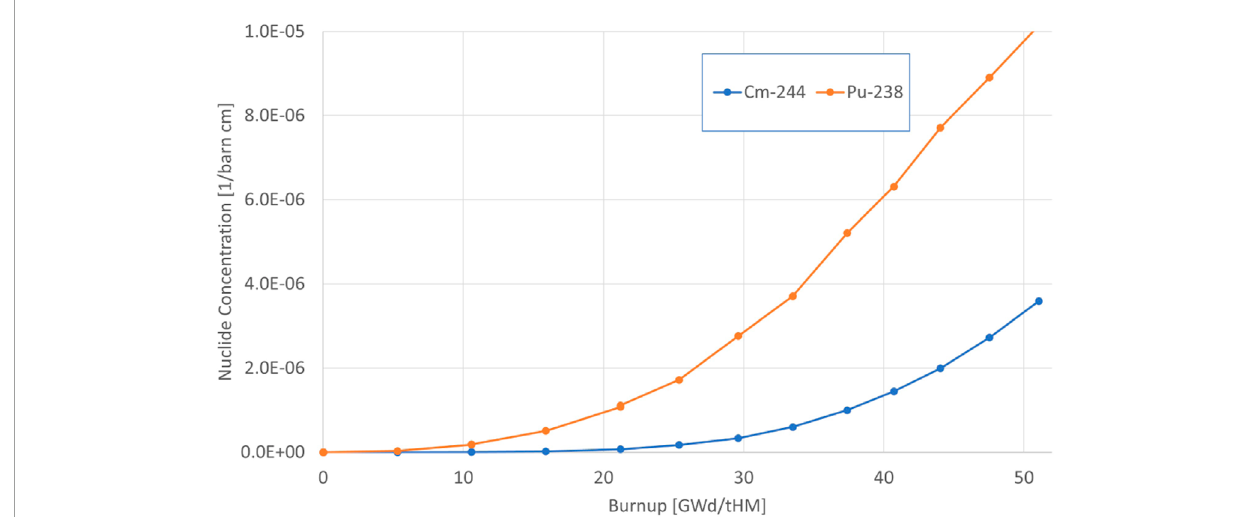
FIGURE 3 Evolution of the concentrations of 244 Cm and 238 Pu with burnup for sample F32 of Ringhals2.